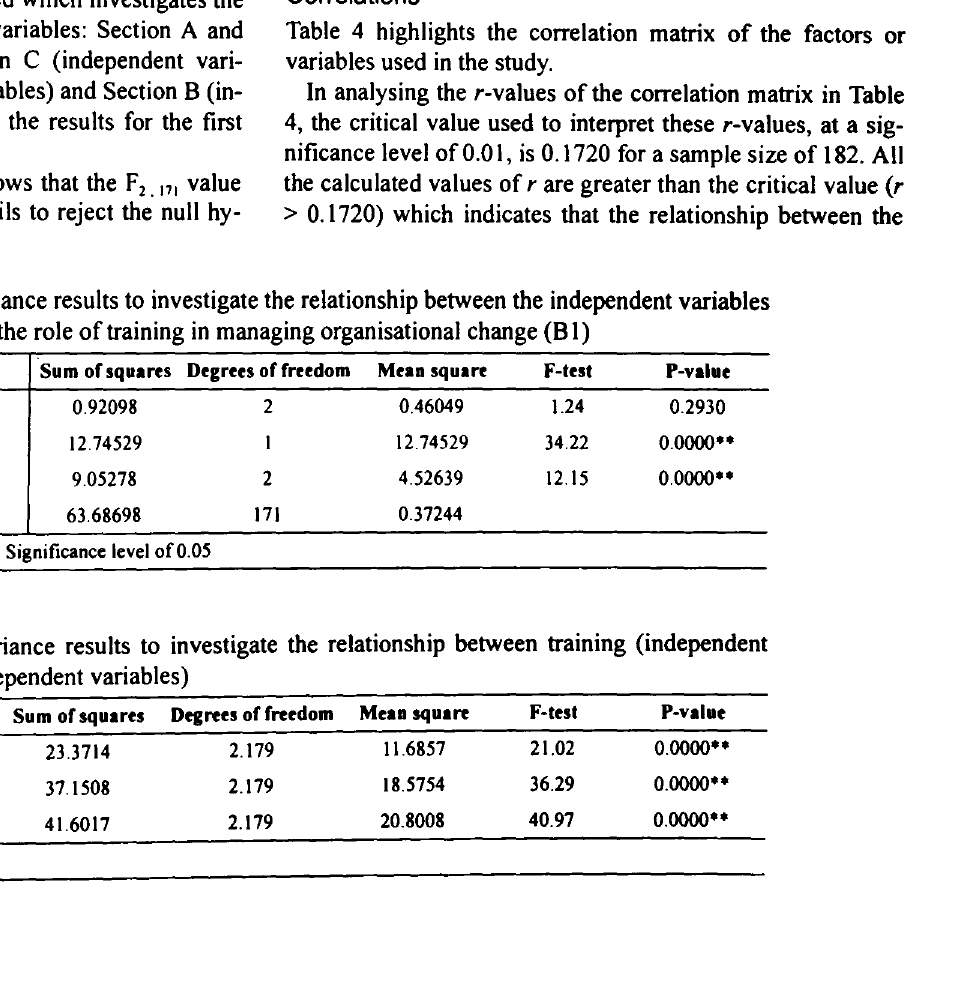
Table 2 Analysis of variance results to investigate the relationship between the independent variables ( classification data) and the role of training in managing organisational change (B 1) Dependent variable (Bl)